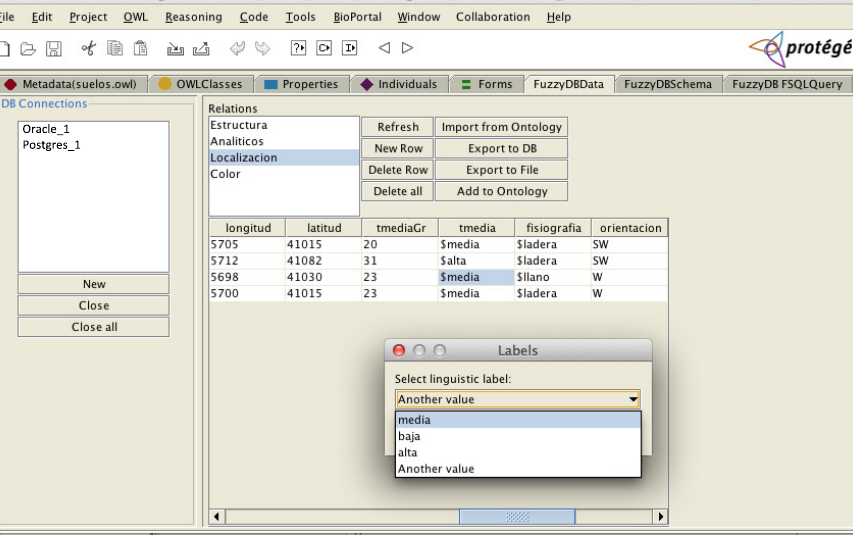
Fig. 9. Prot´eg´e plug-in to define fuzzy